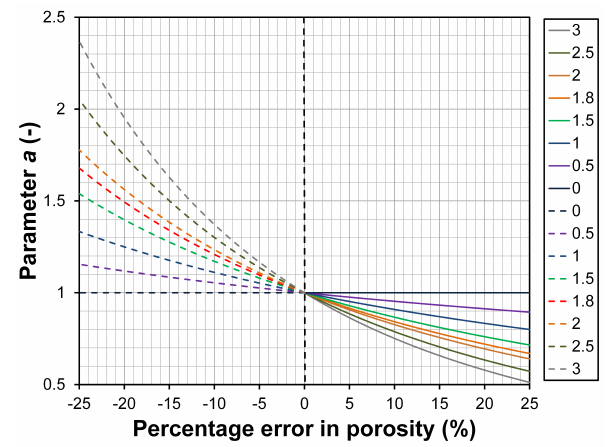
Figure 5. The calculated value of the parameter a as a function of the percentage error in porosity for various values of cementation exponent (given in the legend). The a parameter is independent of the actual value of the